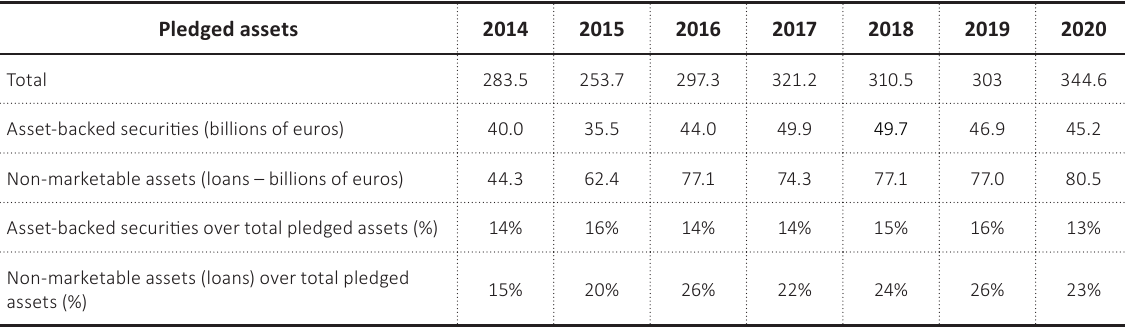
Table A2. Assets pledged as collateral from Italian banks to the Eurosystem